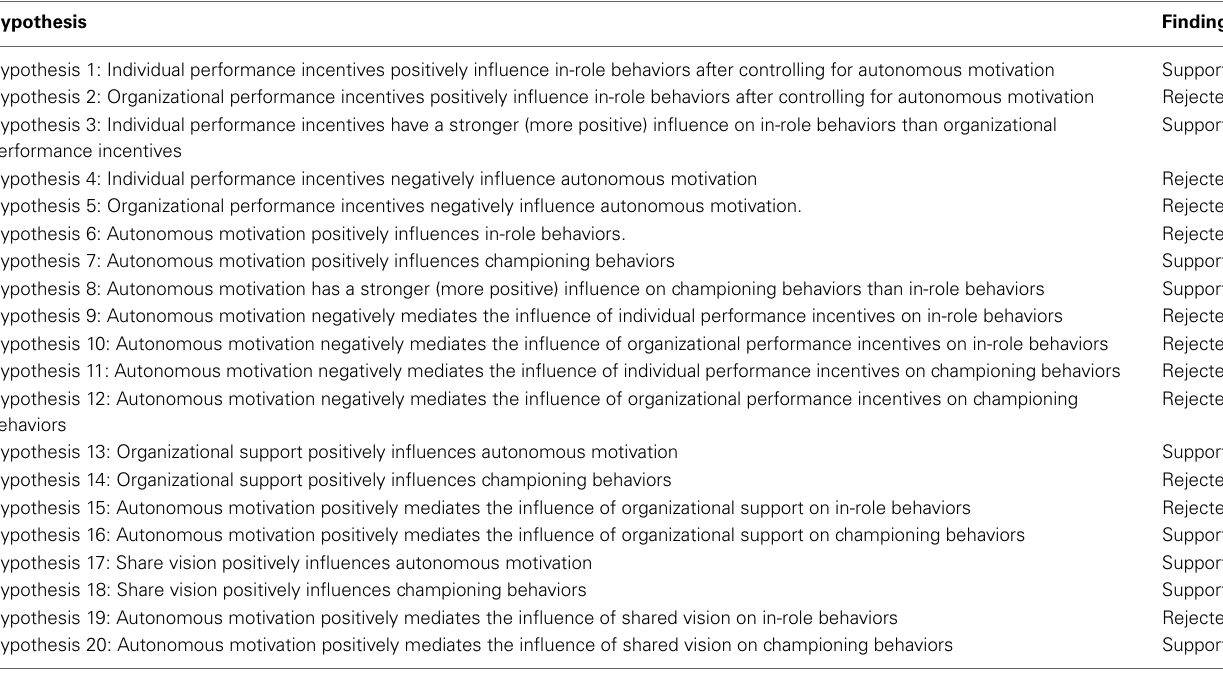
Table 9 | Summary of hypothesis testing.